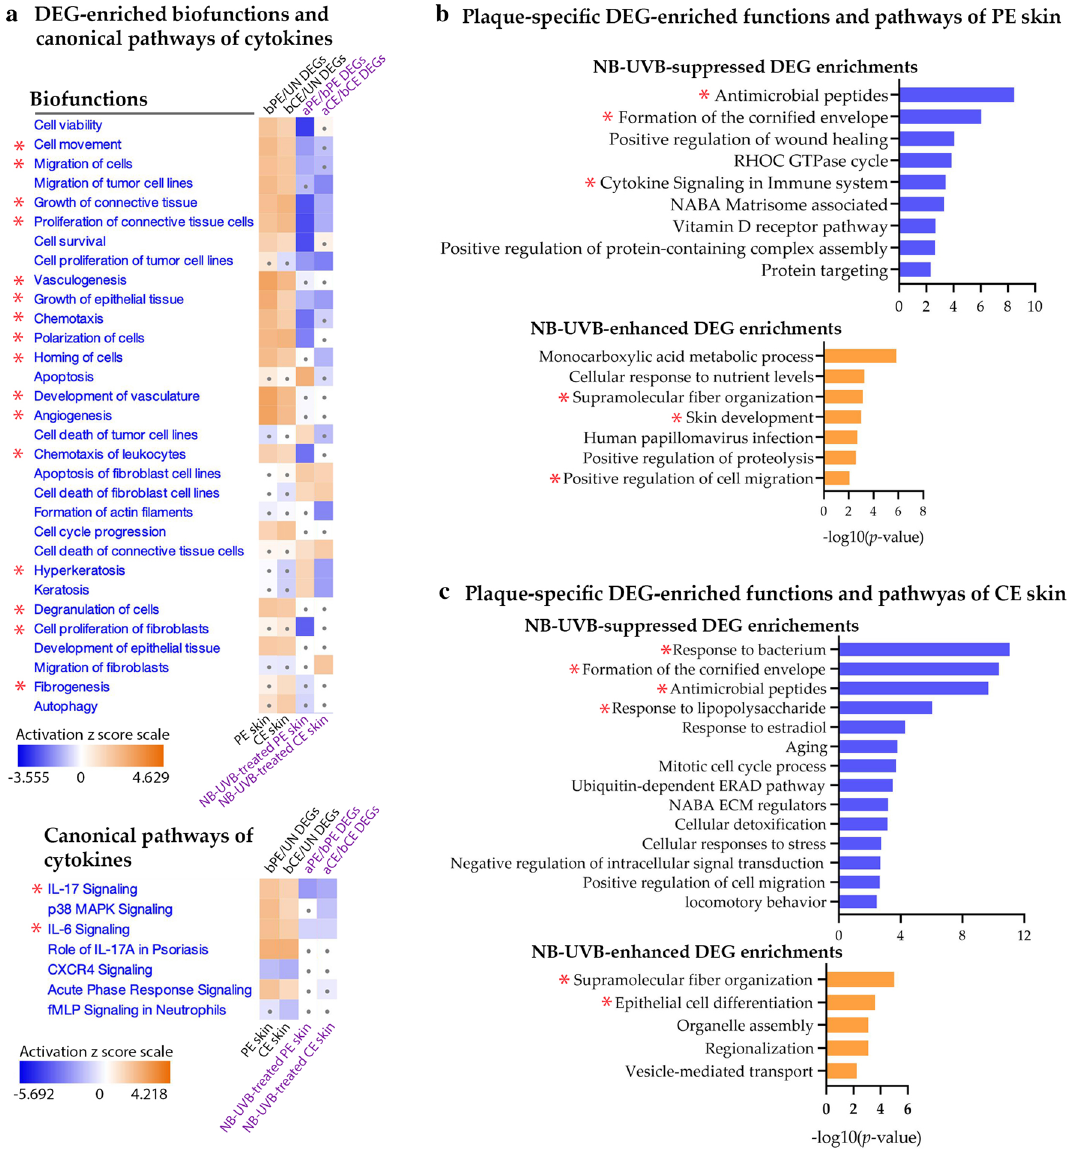
Figure 2. Downstream function analysis. ( a ) DEGs were analyzed for their downstream function and canonical pathway enrichment using QIAGEN’s IPA. The comparison among each set of DEGs is shown with a heatmap of activation z score. Orange, white, and blue colors represent activation, neutral, and inhibition, respectively. A dot is designated for │ z score │ < 1. ( b – c ) Function and pathway enrichment of NB-UVB-altered plaque- specific DEGs of PE and CE skin were analyzed using Metascape. Interesting functions are designated with *. aCE skin After NB-UVB-treated PE skin, aPE skin After NB-UVB-treated CE skin, bCE skin Before NB-UVB- treated center of lesional skin, DEG Differentially expressed gene, bPE skin Before NB-UVB-treated peripheral edge of lesional skin, UN skin Uninvolved